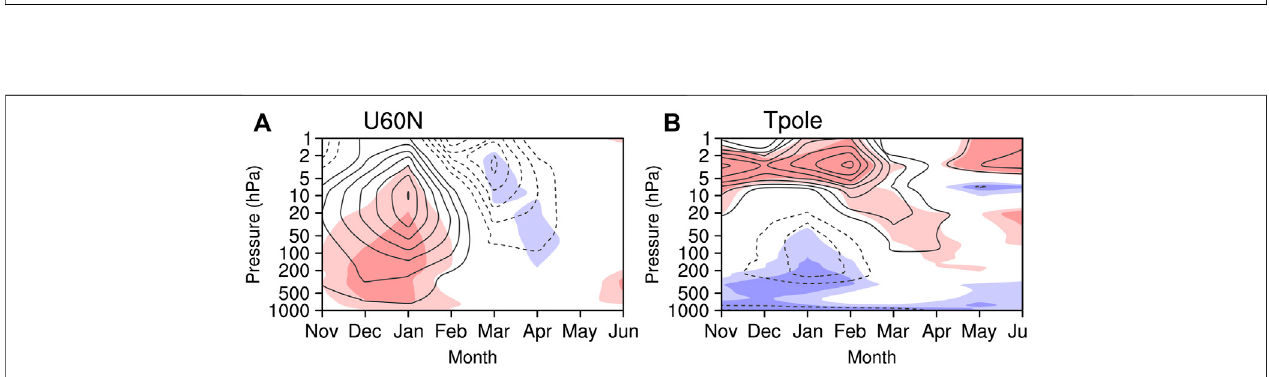
FIGURE 9 | Pressure-temporal evolutions of (A) regressed circumpolar zonal wind anomalies at 60 ° N (units: m/s) and (B) regressed polar cap temperature anomalies (units: ° C) averaged over 60 – 90 ° Nagainst the standardized November – December mean Arctic sea ice concentration in Barents – Kara Seas, representing the stratosphere – troposphere – cryosphere coupling. The dark and light shadings mark the regression at the 90% and 95% con fi dence levels, respectively.